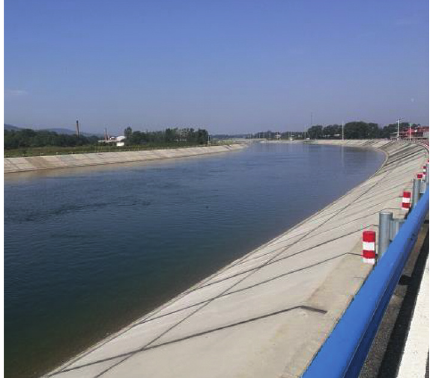
Figure 2: South-to-North Water Transfer channel in Yuzhou city.